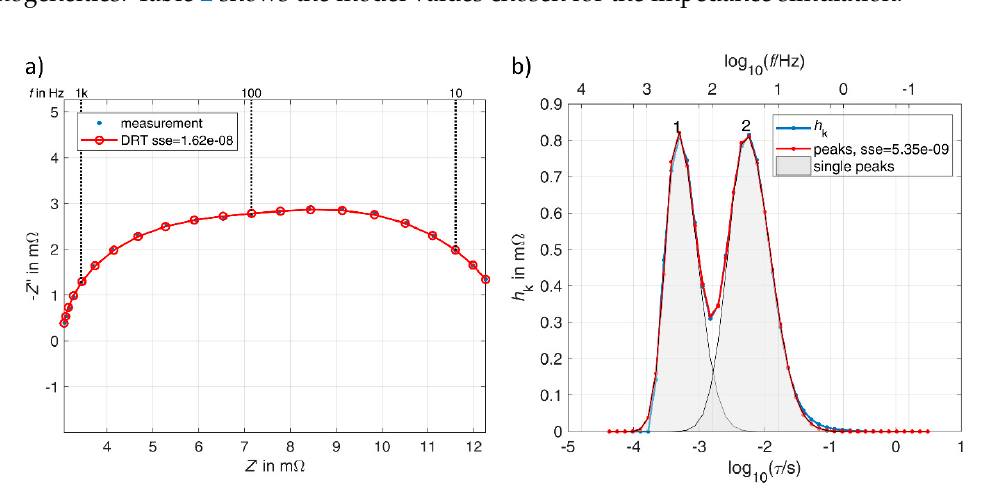
Figure 2. Example spectrum of series connection of an ohmic resistance, an RC element, and a ZARC element. ( a ) Nyquist plot of the spectrum with the sum of squared errors ( sse ) according to Equation (5); ( b ) Distribution of relaxation times h k of the spectrum with fitted peaks and the sum of squared errors of their residual. In legends the engineering notation is used for sse values, where, e.g., 1.62e-08 corresponds to 1.62 · 10 − 8